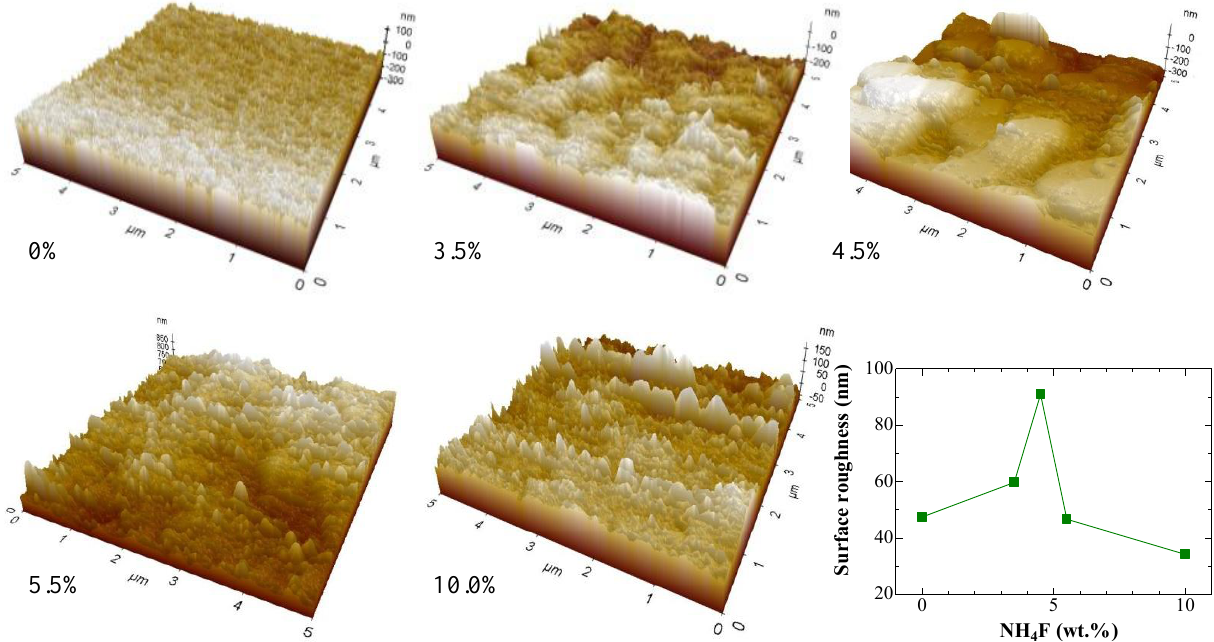
films deposited under different NH 2 F 4